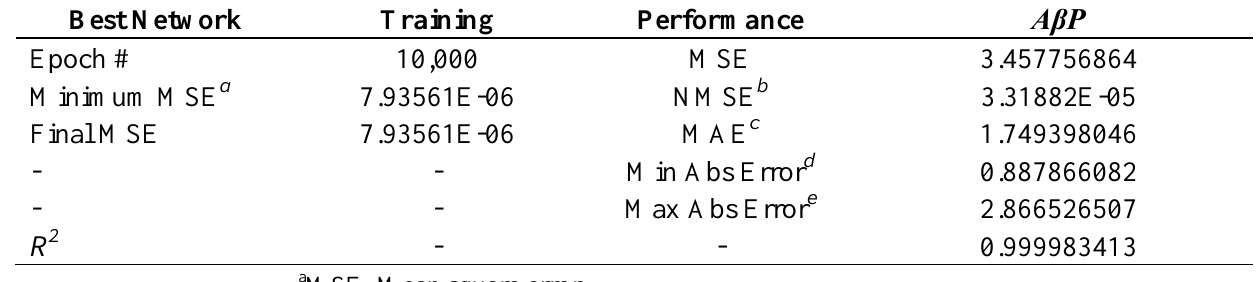
Table 4. Neural network indicators characterizing the efficiency and performance of data in the training as per